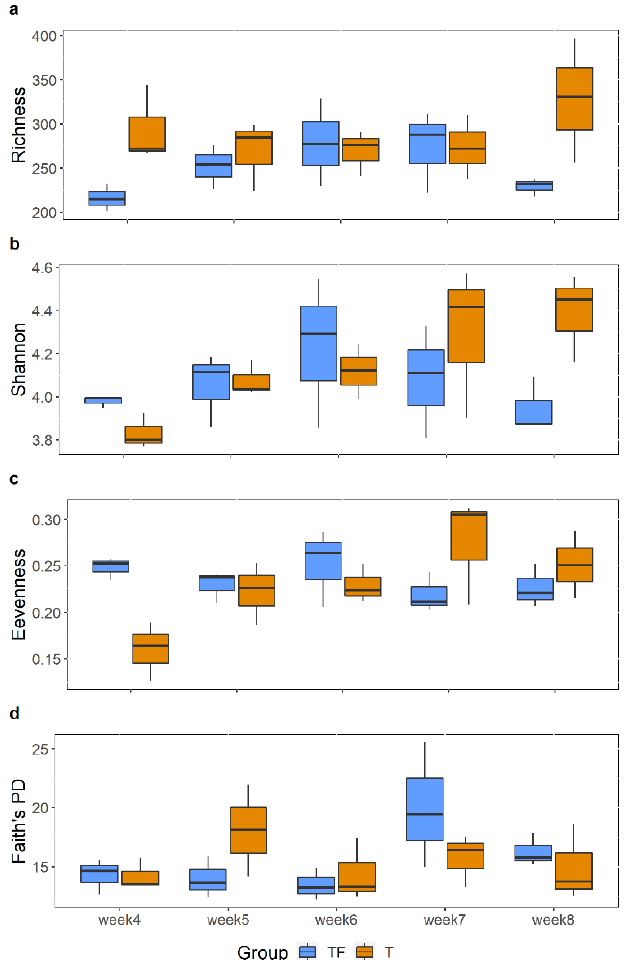
Figure 3. Comparisons of Alpha diversity indexes between TF and T groups at different time points. ( a ) Richness. ( b ) Shannon index. ( c ) Evenness. ( d ) Faith’s PD. Each box displays the alpha diversity distribution for three samples. There is no significant difference between TF and T at all five time points for all alpha diversity indexes (Wilcoxon rank-sum